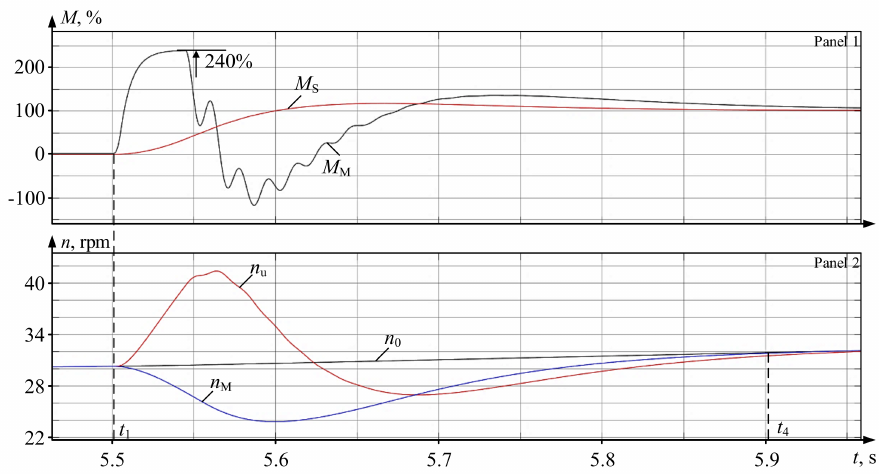
Figure 12. Counterparts of the transients in Figure 11b at an increased second mass speed controller gain. Comparison of the curves plotted in Figures 11b and 12 shows that how fast the second mass speed control loop responds does not significantly affect the performance of two-mass system shaft torque